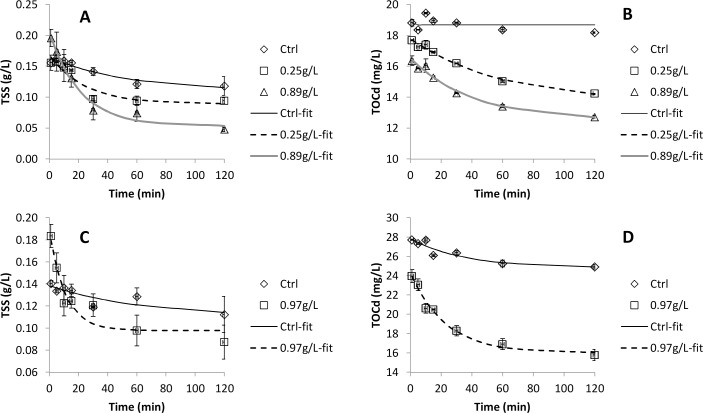
Removal of TSS and TOCd in kinetic tests carried out on two different sampling occasions.The legends show addition of activated sludge in gVSS per litre. Control samples (Ctrl) did not contain added activated sludge. Symbols show measured data whereas lines were fitted using Equation 2. Each measurement point is the average of two replicate tests with the error bars representing the individual measurements.